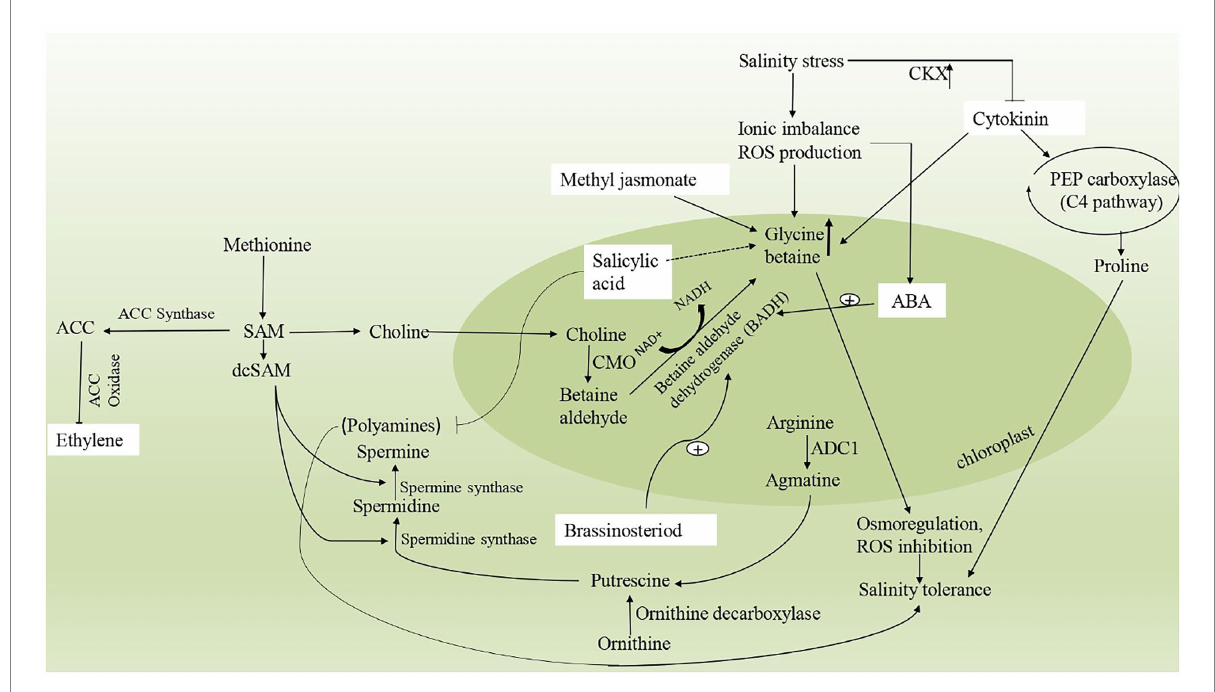
FIGURE 3 A schematic representation describing the interaction of different osmoprotectants with phytohormones under salinity stress. Glycine betaine and Ethylene are interlinked by a common pathway involving enzymes, BADH (betaine aldehyde dehydrogenase), CMO (choline monooxygenase), SAM (S-adenosylmethionine), ACC synthase and ACC oxidase. Polyaminebiosynthesis includes ornithine and arginine decarboxylation, catalyzed by ornithine decarboxylase (ODC) and arginine decarboxylase (ADC), respectively. Spermidine (Spd) is synthesized from putrescine via spermidine synthase (SPDS) with the addition of aminopropyl moiety donated by decarboxylated S-adenosylmethionine (dcSAM). Similarly, Spermine (Spm) is produced from spermidine (Spd) via spermine synthase (SPMS) with the same aminopropyl rendered by dcSAM. Cytokinins are deactivated by CKX1 (cytokinin oxidase/dehydrogenase) gene on exposure to high salinity